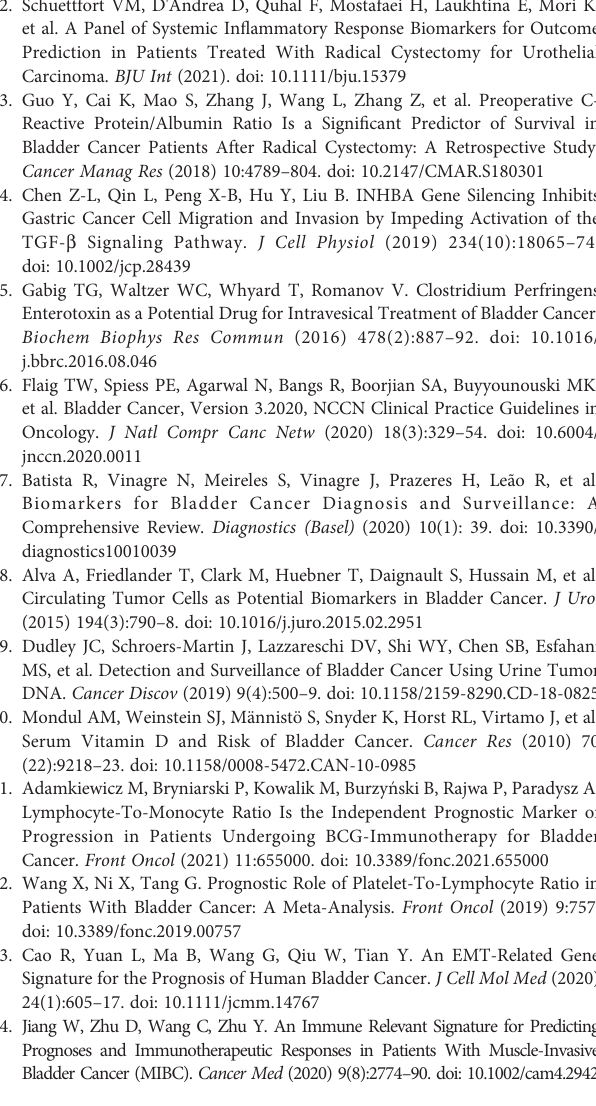
Supplementary Figure 1 | Forest plots showing the results of the association between IRAGs and OS. Supplementary Figure 2 | AUC time-dependent ROC curves for OS in GSE13507 cohort. Supplementary Table 1 | The 200 in fl ammatory response-related genes. Supplementary Table 2 | Differentially expressed genes between HCC tissues and adjacent non-tumorous tissues in TCGA. Supplementary Table 3 | The primer sequences of the prognostic genes. Supplementary Table 4 | The level of prognostic genes in NCI 60 human cancer cell lines. Supplementary Table 5 | Marker genes for immune cell